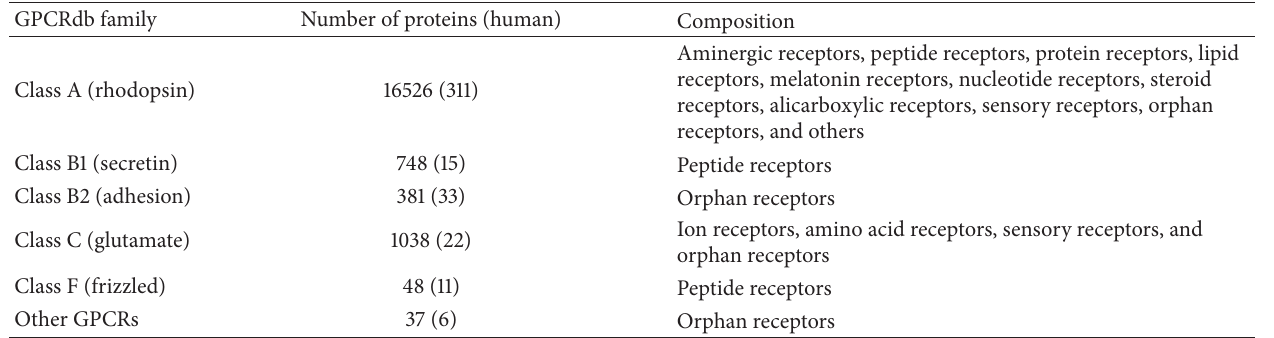
Table 1: The number of proteins and composition for every class of GPCRs (from